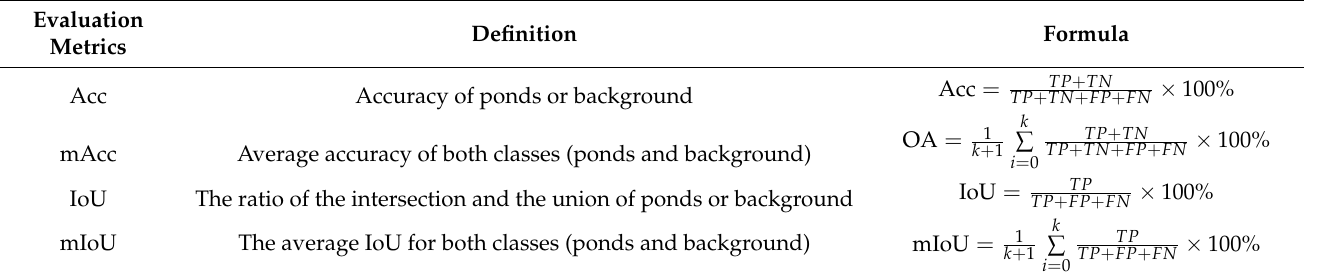
Table 1. Evaluation metrics of ponds extraction